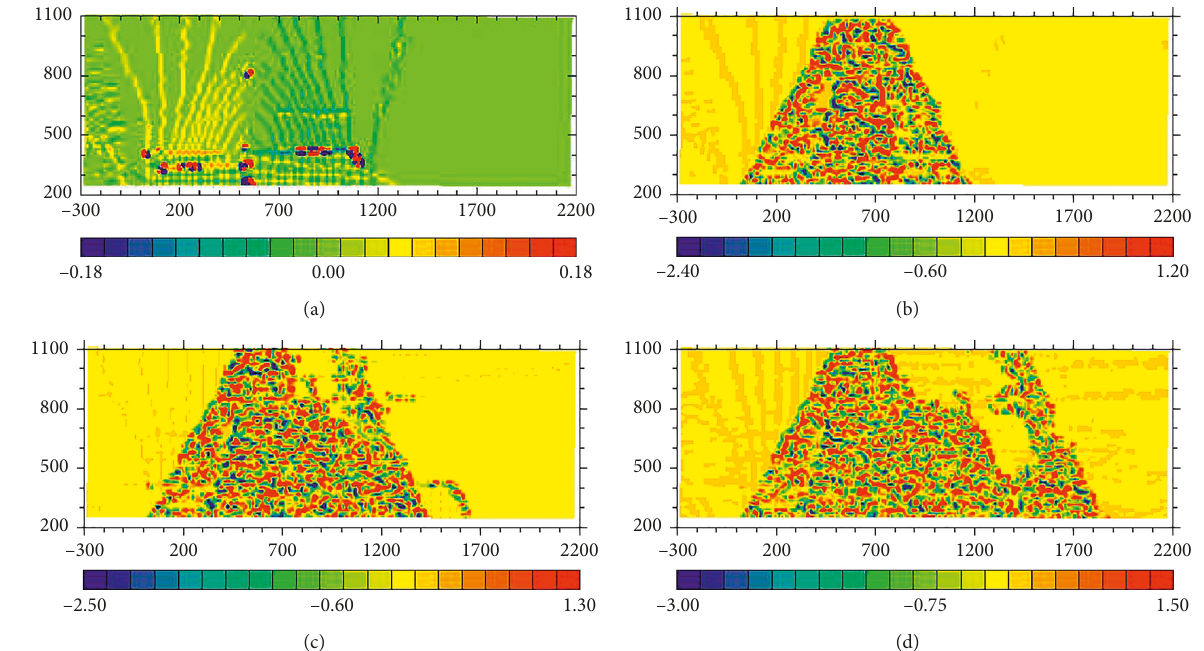
Figure 11: The distribution of shearing strain during excavation. The coal stratum is excavated to (a) 120m, (b) 130m, (c) 165 m, and (d) 190m.